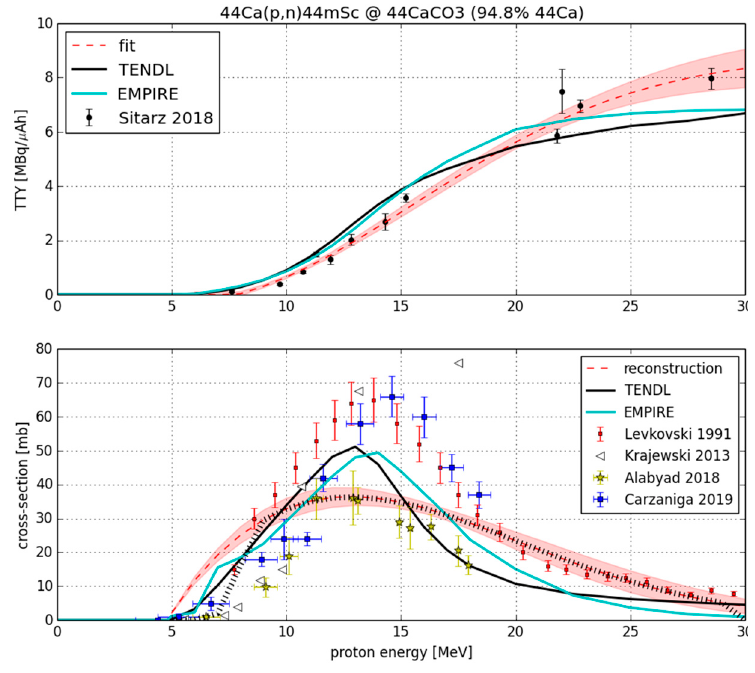
Figure 3. Reconstruction of 44 Ca(p,n) 44m Sc cross-section (bottom) based on the fit to TTY data on 44 CaCO 3 enriched in 94.8% 44 Ca (top). The cross-section data points are taken from [31,32,34,35].